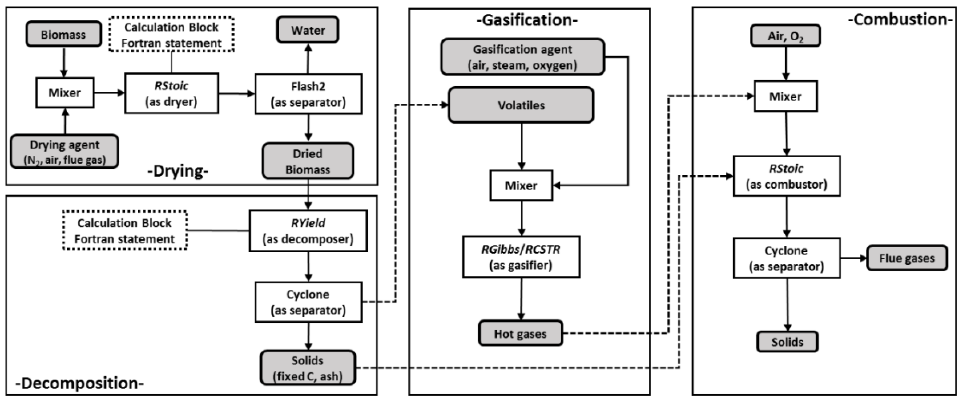
Figure 4. General Aspen Plus process flowsheet of biomass gasification (Grey boxes indicate com- pounds) [110]. (Reprinted from Chemical Engineering & Technology, Vol 43 (9), O.C. Mutlu and T. pounds) [110]. (Reprinted from Chemical Engineering & Technology, Vol. 43 (9), O.C. Mutlu and